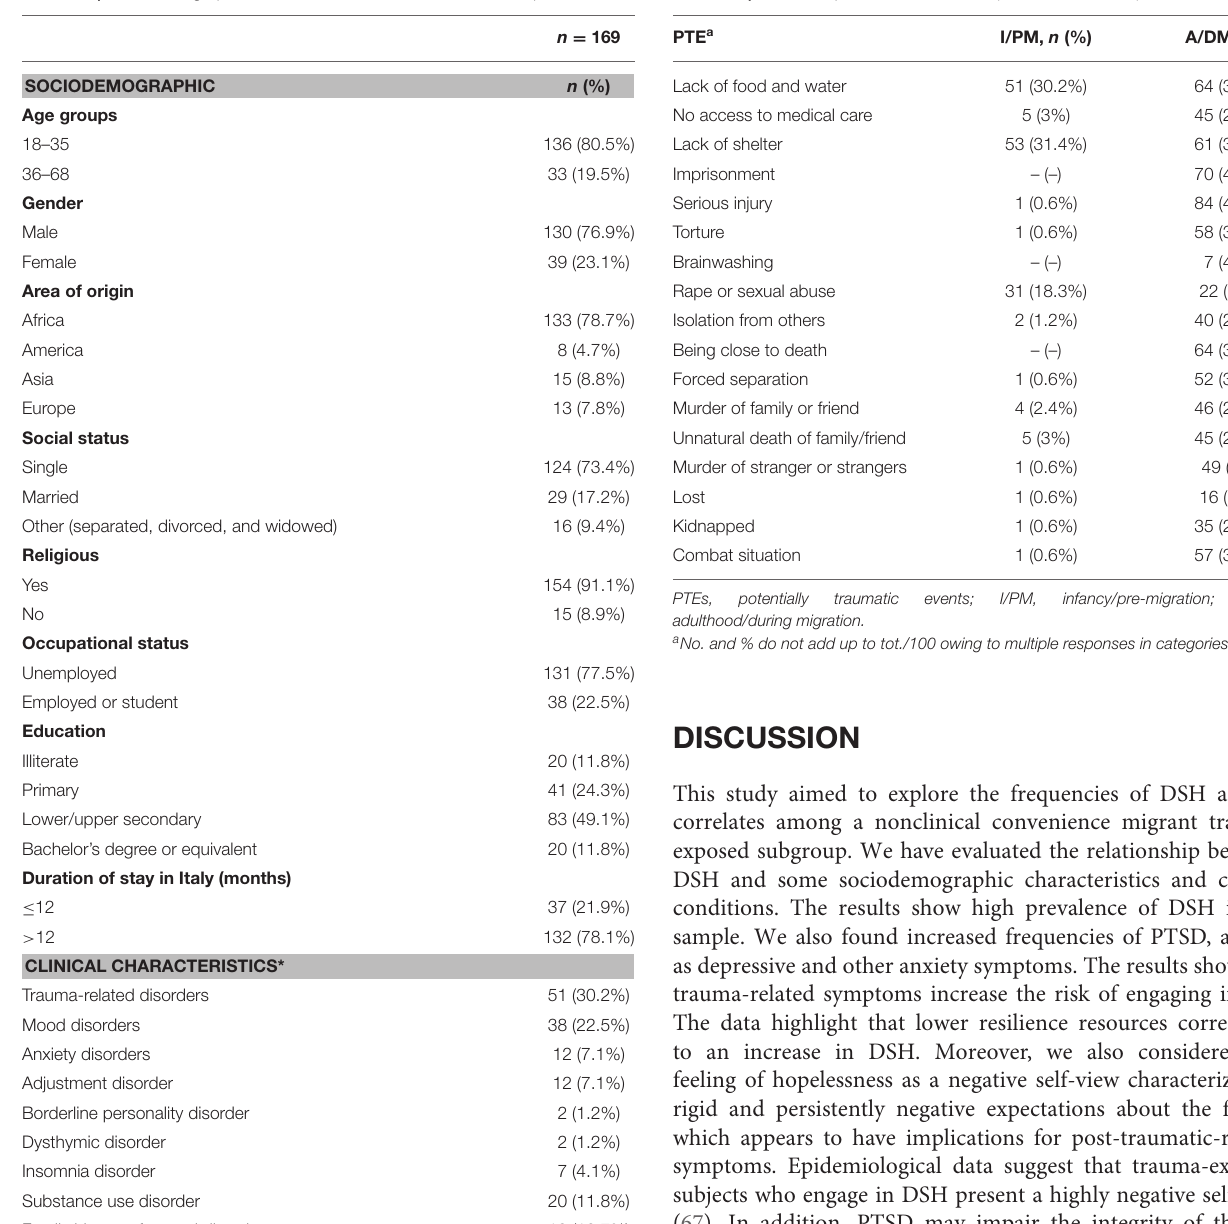
TABLE 1 | Sociodemographic and clinical characteristics of the sample. TABLE 2 | PTEs and period of occurrence (I/PM and/or